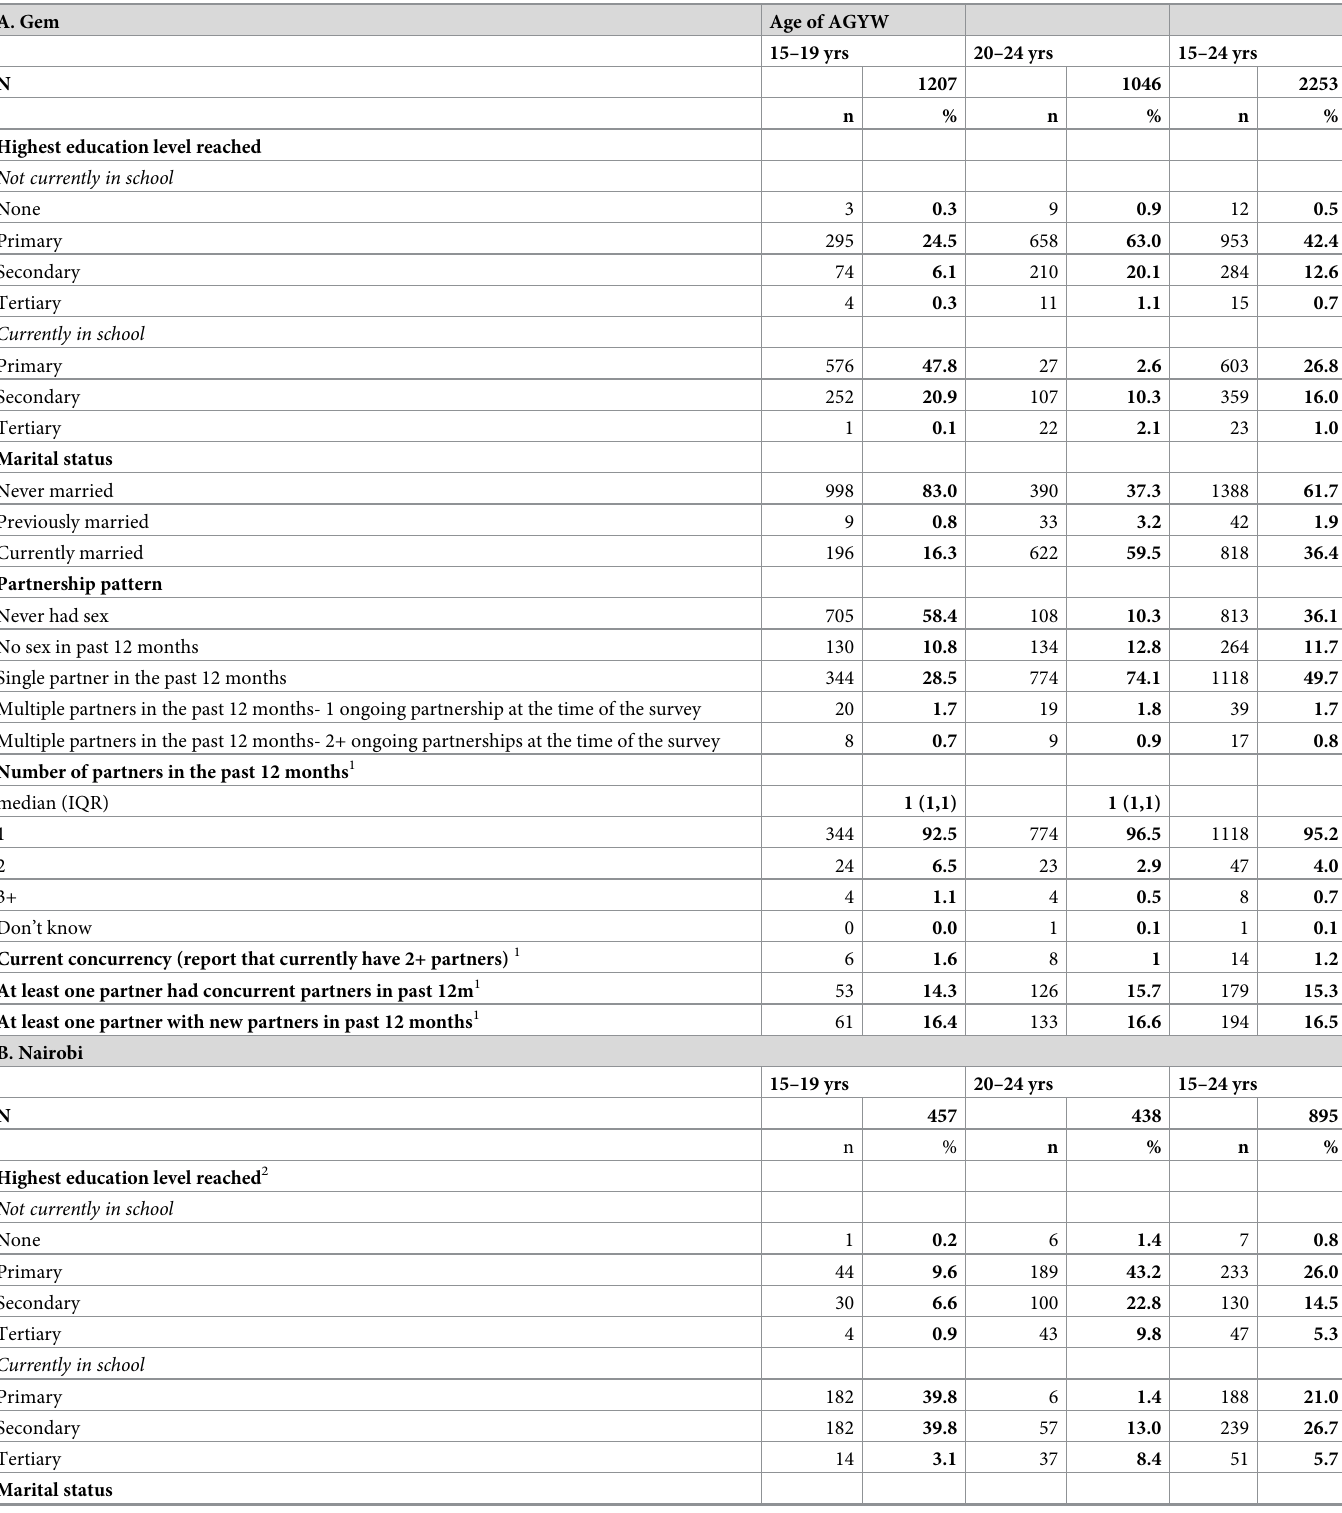
Table 2. Marital status, education and sexual behaviour reported by